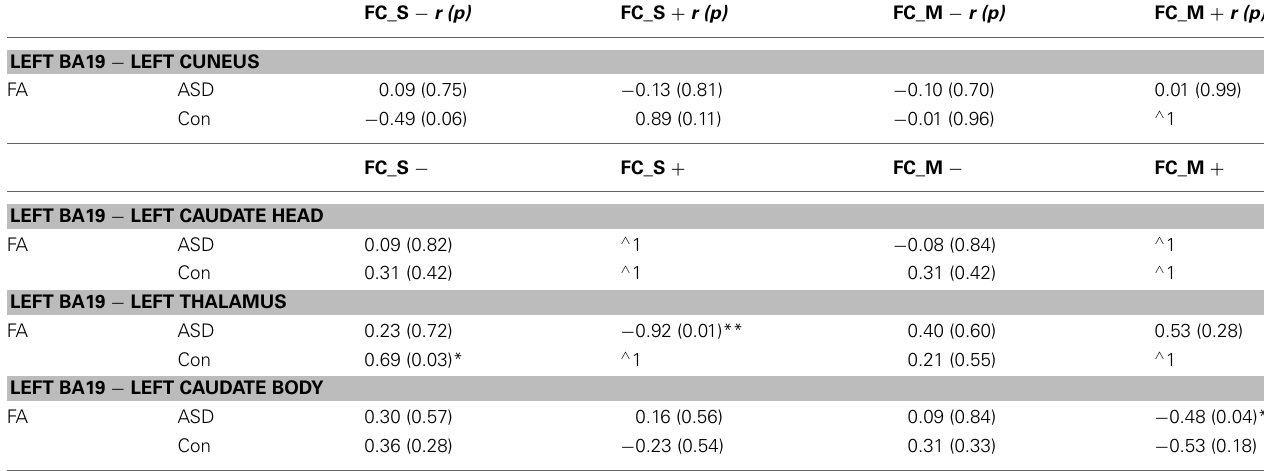
Table 7 | Results of correlation analysis between diffusion measures in white matter tracts and functional connectivity during Same and Mirror trials of a mental rotation task ( p , p -value; r , Pearson correlation co-efficient; FC_S − Negative functional connectivity on Same trials; FC_S + Positive functional connectivity on Same trials, FC_M − Negative functional connectivity on Mirror trials, FC_M + Positive functional connectivity on Mirror trials, Con: Control, ∧ 1 Insufficient data for correlation as all functional connectivity values were negative between seed regions in left BA19 and left caudate head).